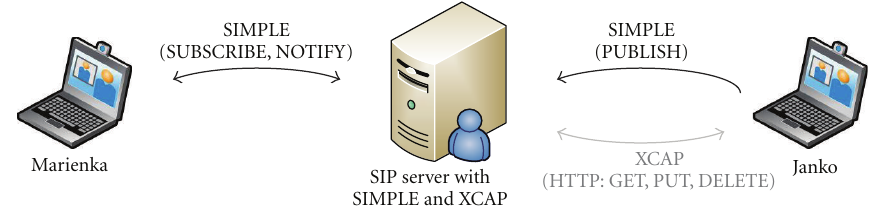
Figure 2: SIMPLE with XCAP